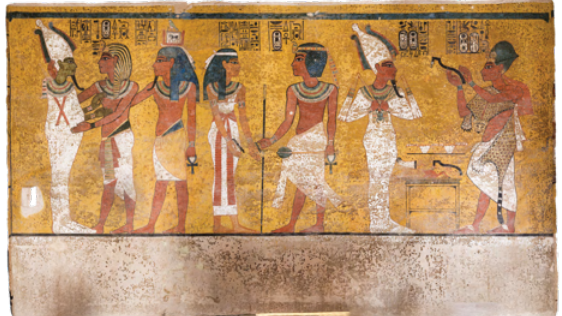
Figure 3: ortho-corrected image of the as-found condition of the north facade of the burial chamber of the Tomb of Tutankhamen after conservation, The Getty Conservation Institute and Carleton University.